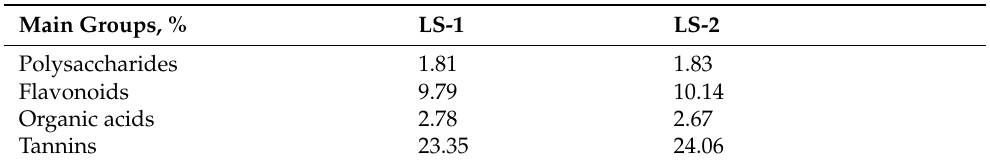
Table 3. Comparative quantitative content of biologically active compounds in LS-1 and LS-2 extracts from S. deserta Schang.